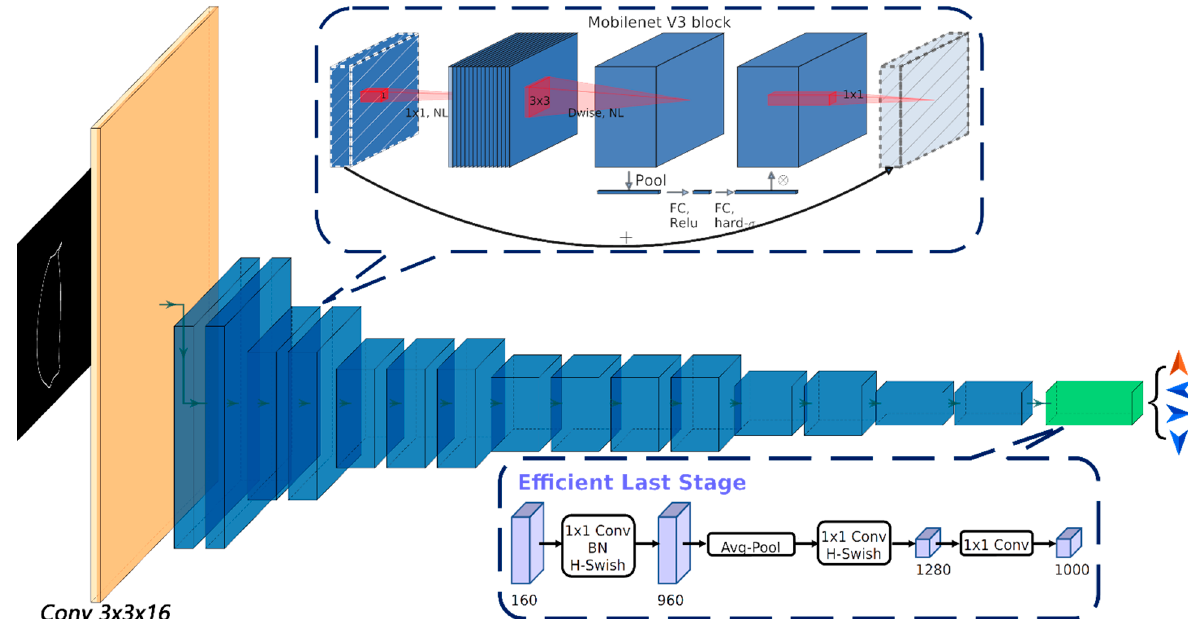
Figure 11. Structure of MobileNetV3.